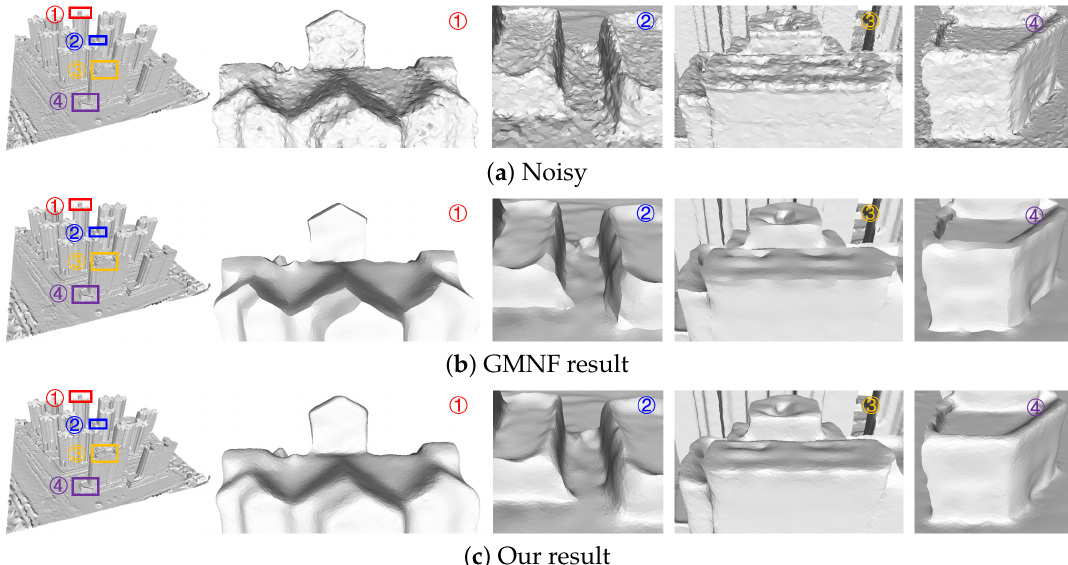
Figure 19. Comparison of denoising results for the City model reconstructed from oblique images.